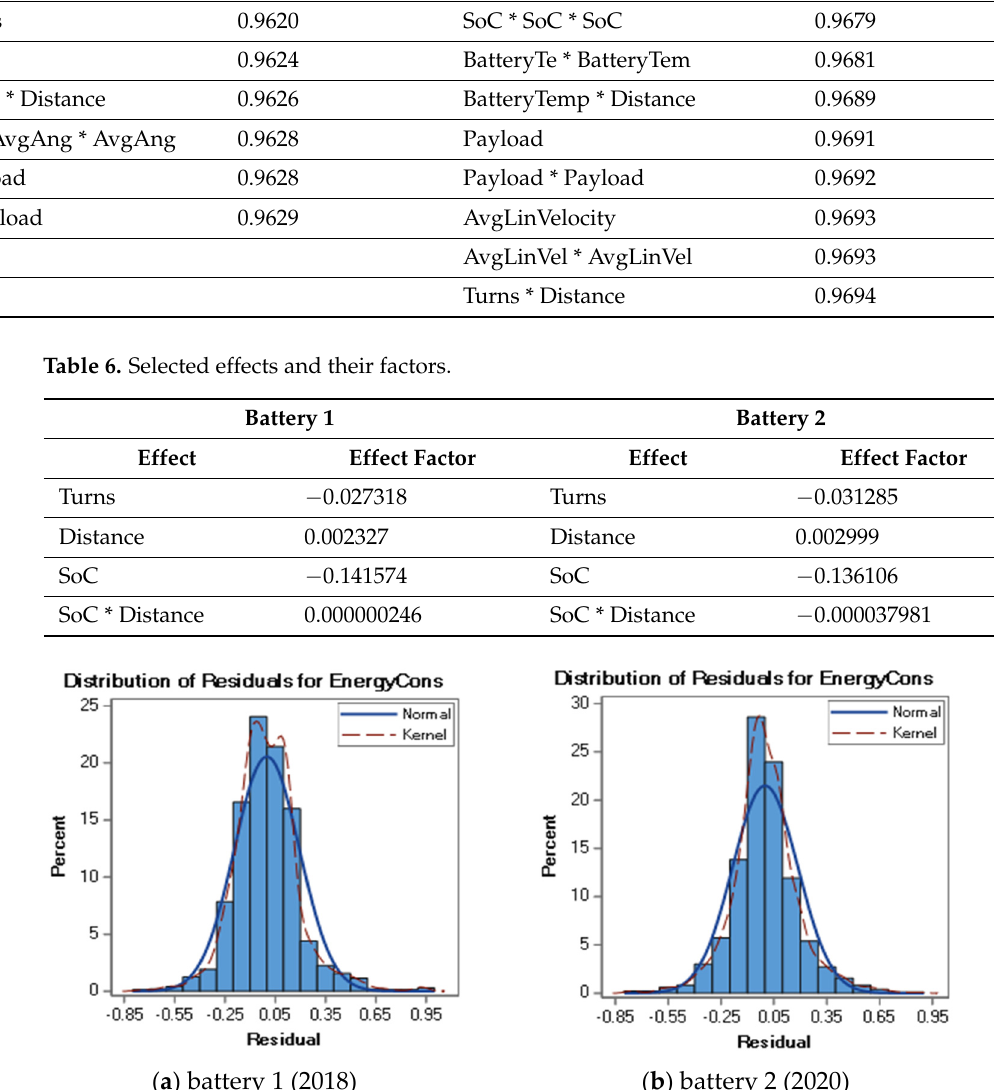
Table 6. Selected effects and their factors.